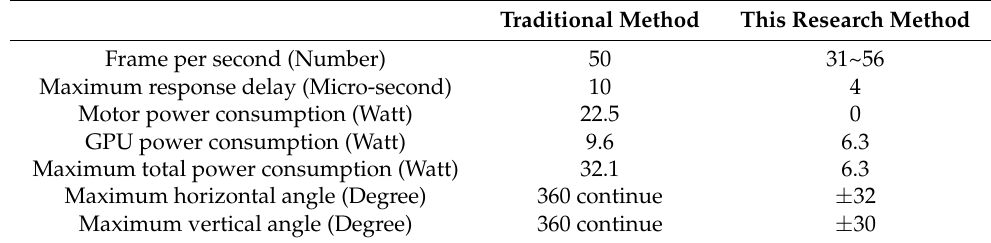
Table 4. Comparison table between the traditional method with motor drive and the method used in this